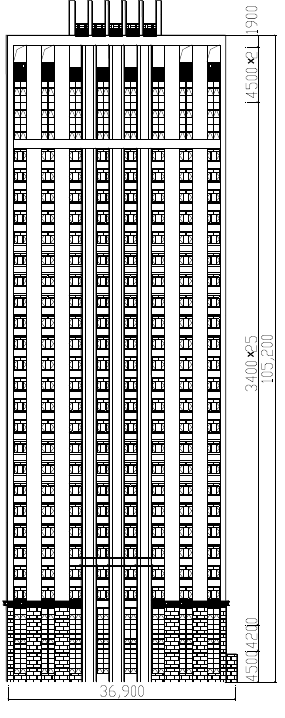
Figure 1. Plan of a typical floor (The black block is the sensor position; unit: mm).